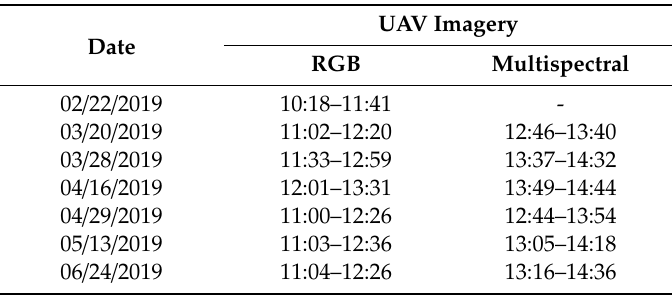
Table 1. An overview of the data acquisition using the unmanned aerial vehicles within the 2019 growing season. Flight times (start time–end time) are expressed in local